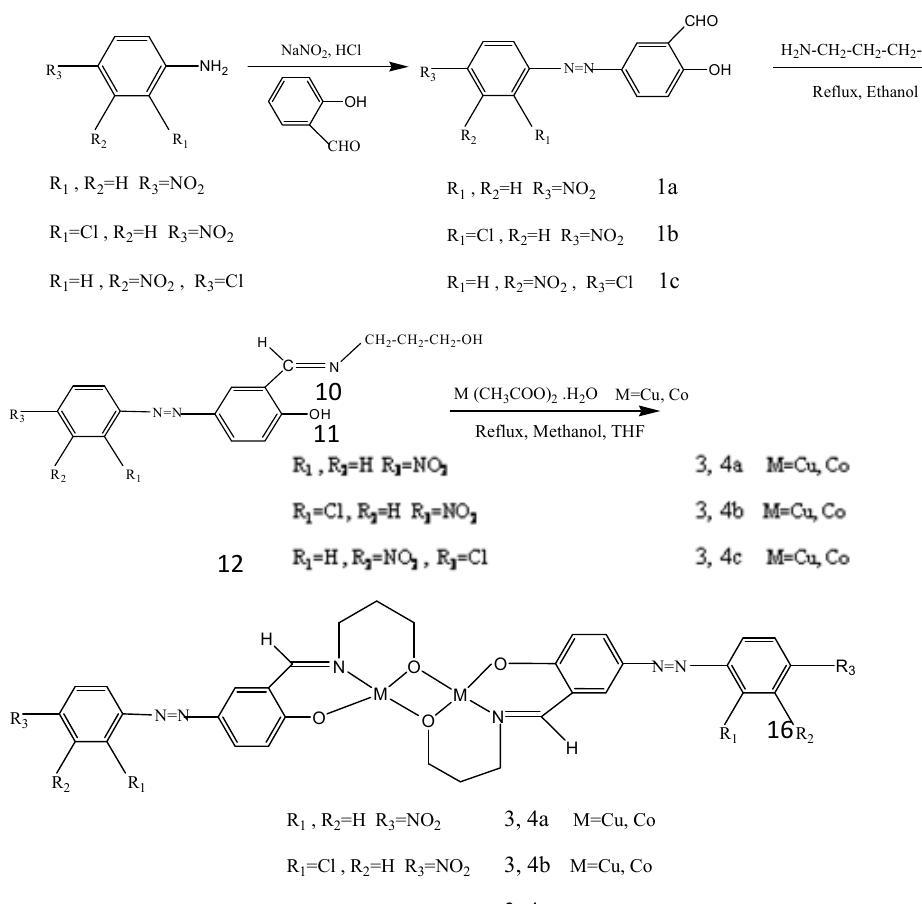
Scheme 1. Preparation of ligands and